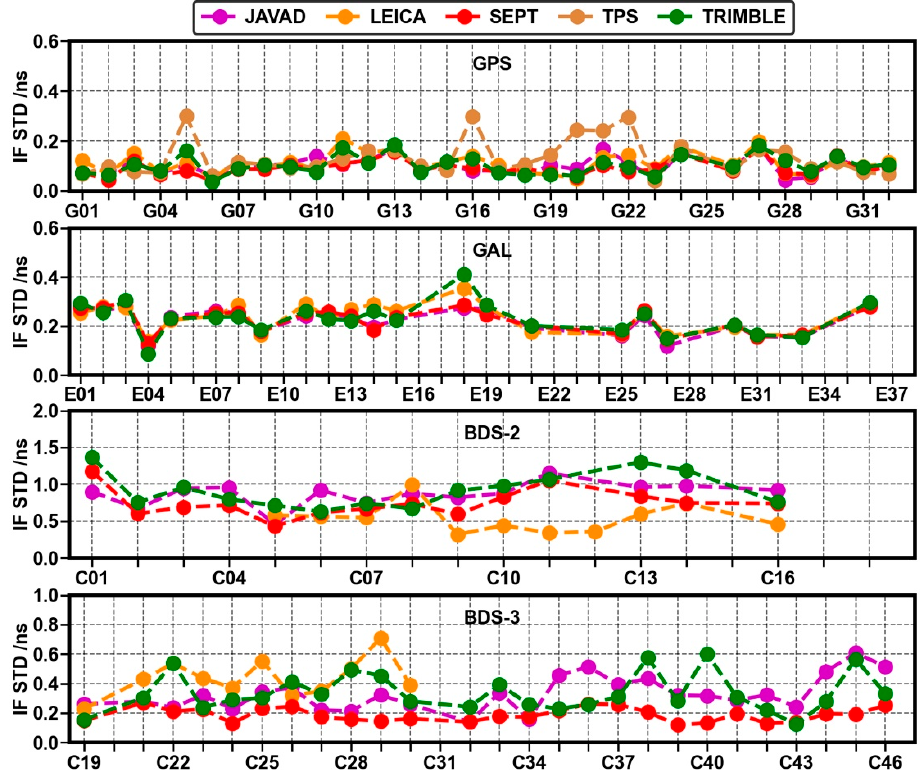
Figure 5. Average STDs of the IF SDBs for multi ‐ GNSS from DOY 45 to 51, 2021.